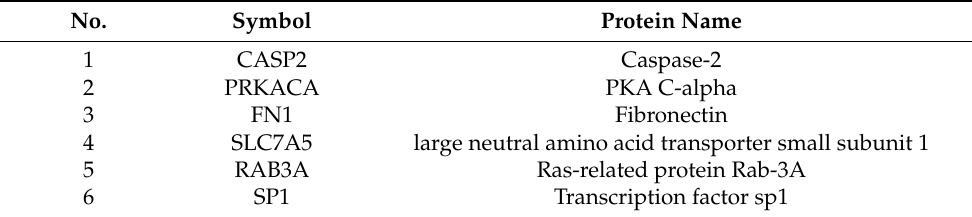
Figure 3. Gene Ontology (GO) functional annotation ( A ) and enrichment analysis ( B ) The top 10 biological processes. ( C ) Four cellular components. ( D ) The top 10 molecular functions. ( p value ≤ 0.05). The colour scales indicate the different p values, and the sizes of the circles represent the number of proteins enriched in each GO term. Table 6. The six potential targets of stemazole combined with diseases databases. No. Symbol Protein